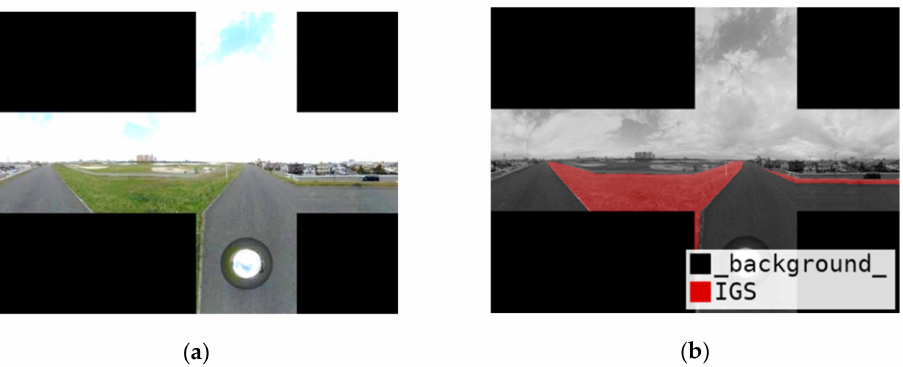
Figure 5. Images processed by Labelme. The source image ( a ) was marked in all IGSs using the Labelme program and saved as a JSON file. ( b ) Visualization of the result, with the red zone representing IGSs and grey and black representing other